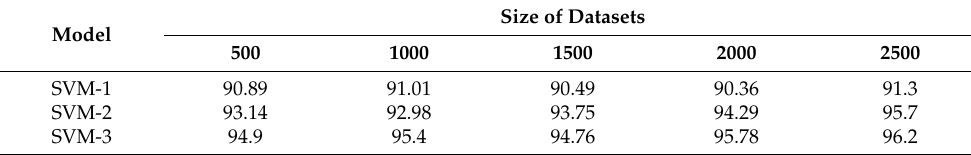
Figure 8. Test results for ANOVA—Dunnett simultaneous statistical test. Table 6. Classification Accuracy of All SVM models for different datasets.